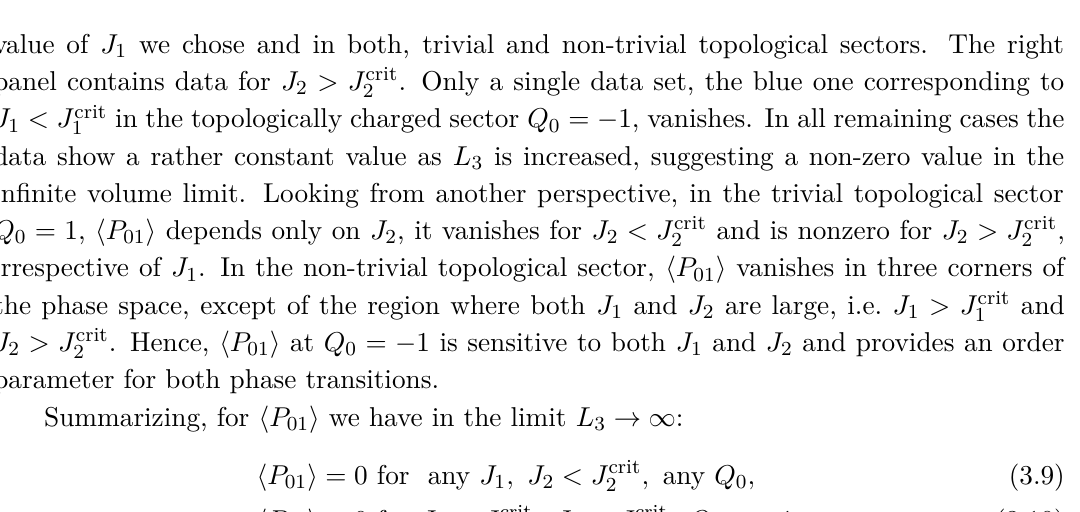
Table 1 . Assembled average values of h P 01 i in the four regions of phase diagram estimated on a lattice with L = 4 and L = 40 3